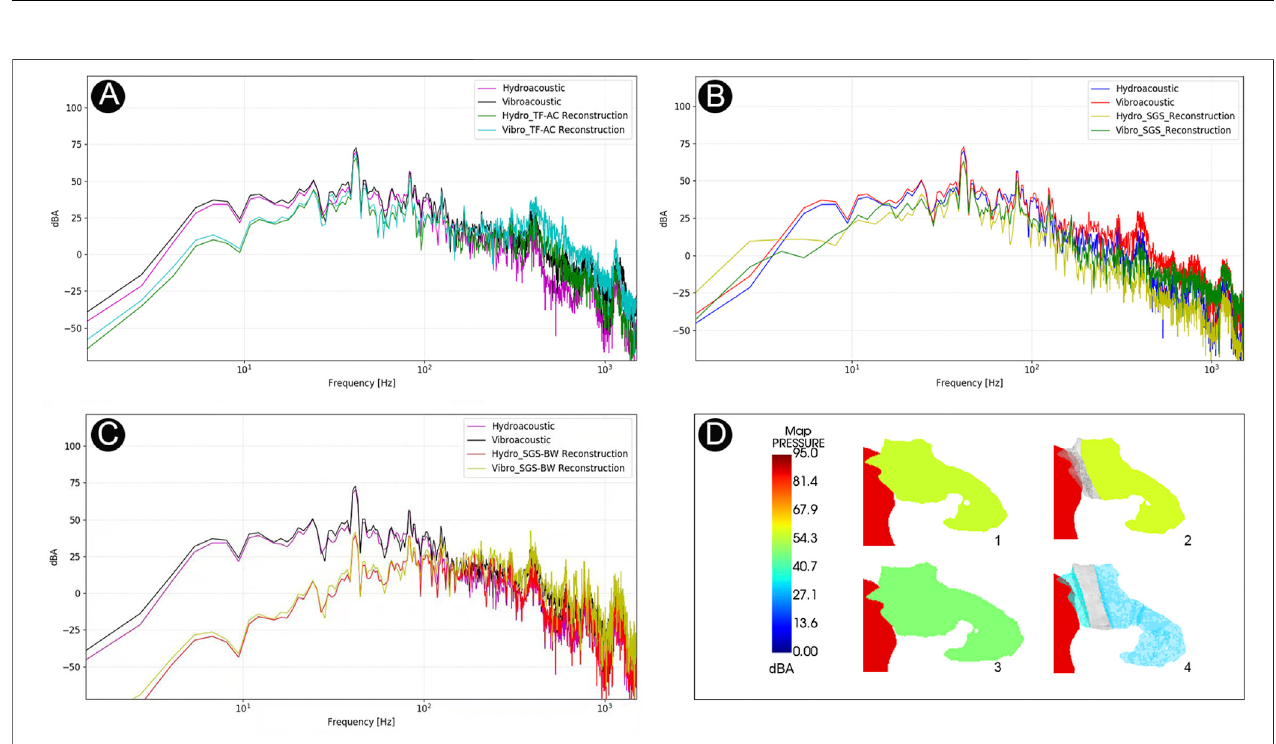
FIGURE8| Computational resultsofamplitudeofPTandsoundinsulationresultsamongdifferenttranstemporalrepair techniques. (A) Theamplitudespectrumof surgical ef fi cacy after temporalis fascia – auricular cartilage (TF-AC) surgical material repair. (B) The amplitude spectrum of surgical ef fi cacy after solidi fi ed gelatin sponge (SGS) surgical material repair. (C) The amplitude spectrum of surgical ef fi cacy after solidi fi ed gelatin sponge – bone wax (SGS-BW) surgical material repair. (D) Visualization of PT transmission inside the middle-ear cavity.